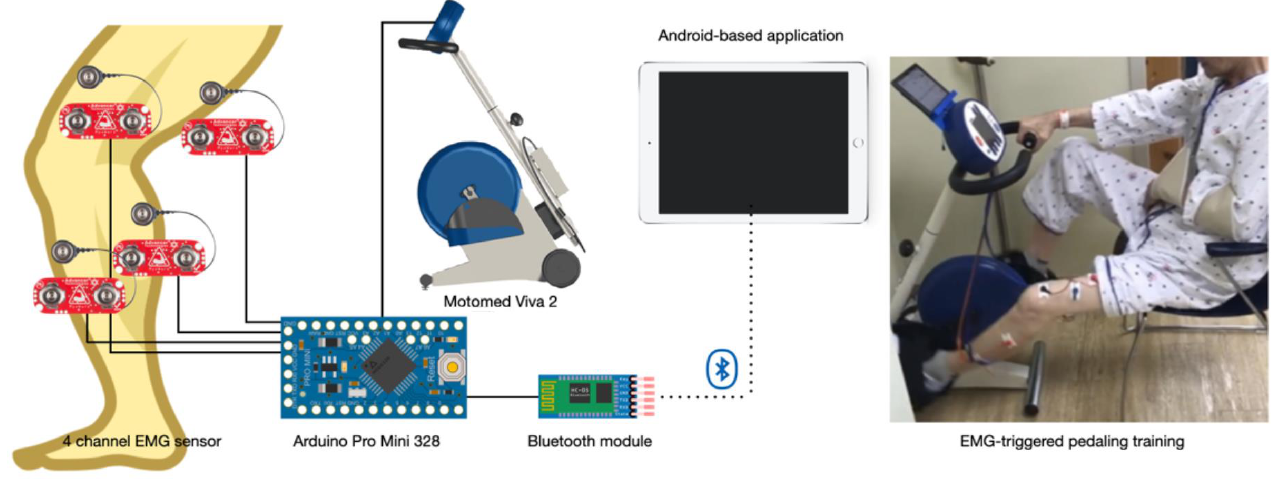
Figure 2. EMG-triggered pedaling training device.